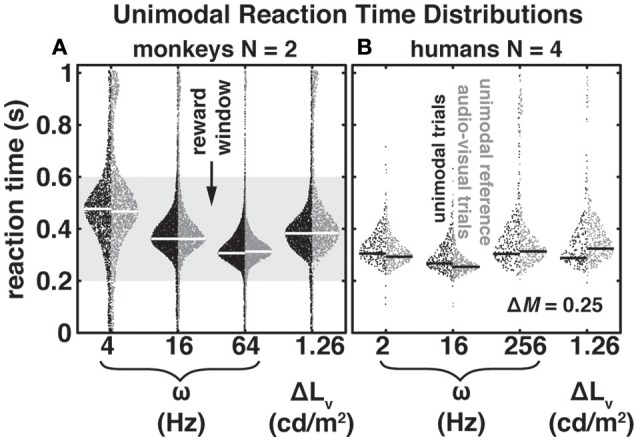
Bee-swarm plots for unimodal (black) and audio-visual (dark gray) reaction times (RTs) as a function of modulation frequency, ω, and luminance difference, ΔLv, for two monkeys (A) and four humans (B). In the auditory trials modulation depth, ΔM, was 0.25. For auditory and visual audio-visual RTs we selected data in which either the auditory or visual change led by 600 ms. These conditions can be considered “unimodal” since the far majority of RTs was < 600 ms for all stimuli. Dots indicate individual RTs and white (monkeys) and black (humans) horizontal lines the mode of the distributions. Note that in contrast to the monkeys, humans were not rewarded and did not receive feedback for responding within the reward window (gray patch in A).